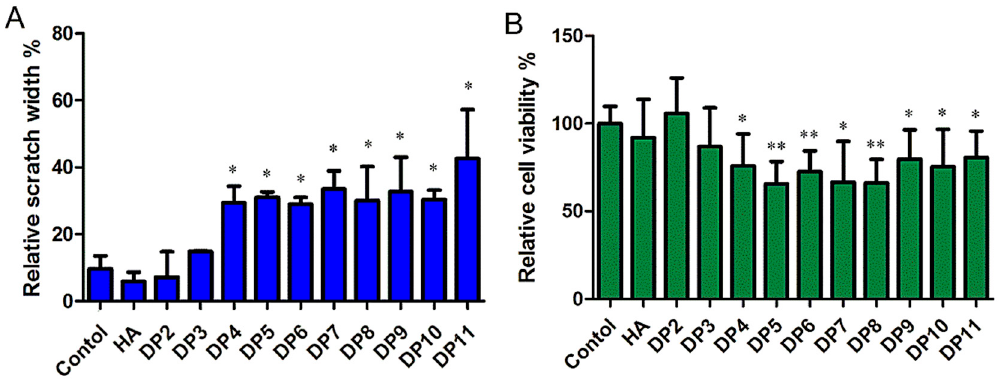
Figure 7. The migration and growth of MDA-MB-231 induced by HAOs. ( A ) Scratch width of the control in the presence of HAOs at 100 mmol/L for 48 h. ( B ) Relative cell viability after 48 h treatment with 100 mmol/L HAOs. Data represent the mean ± SD with reference to the PBS treatment group. * p < 0.05, ** p < 0.01; one-way ANOVA with Tukey’s multiple comparisons test.